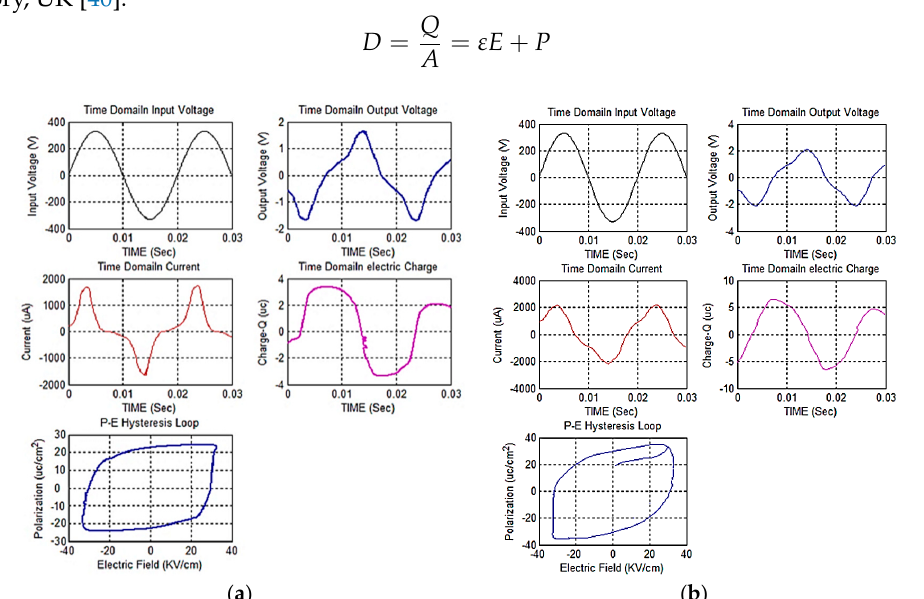
Figure 11. Ferroelectric ( P-E ) hysteresis loop for the composite piezo-films: ( a ) L 1 -A and ( b ) L 1